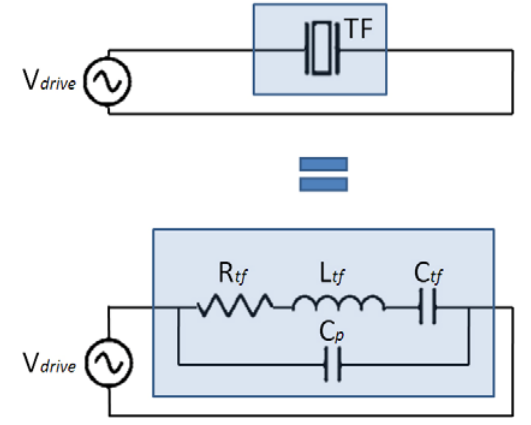
Figure 1. Butterworth-Van Dyke equivalent circuit for the tuning